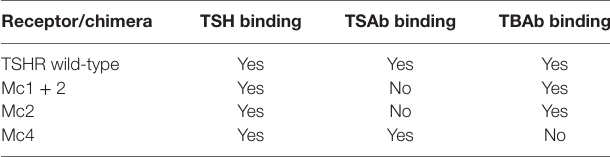
TABLe 2 | Summary of functional properties of TSHR–LH/CGR chimeras.